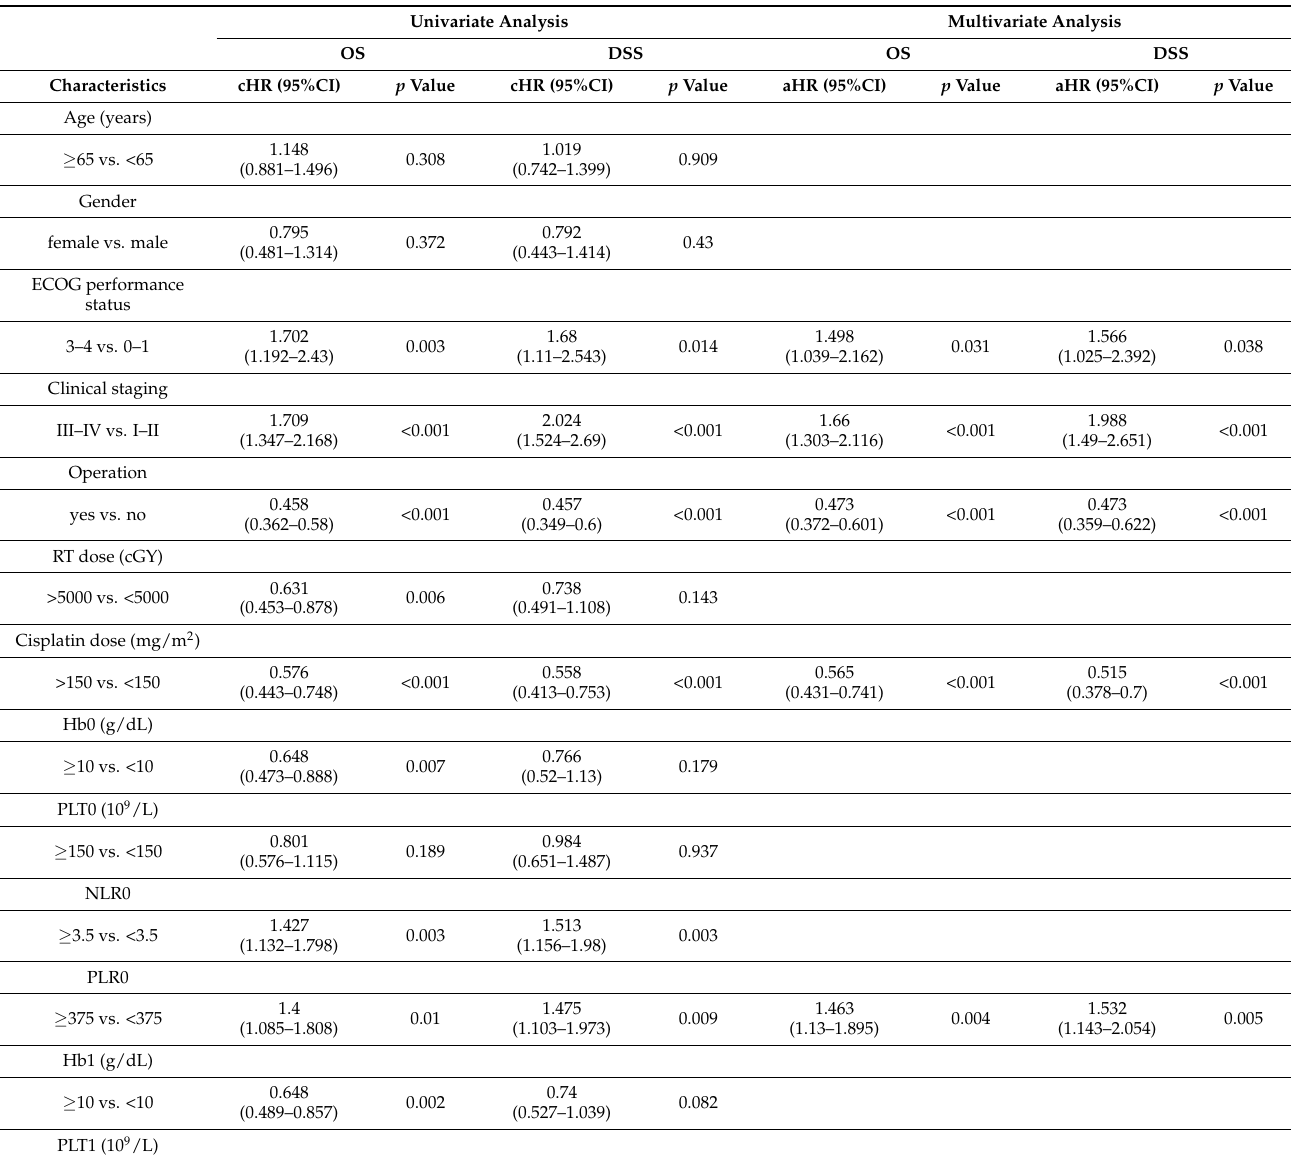
Table 2. Univariate Analysis and Multivariate Cox proportional Hazard Regression Analysis for OS and DSS. Univariate Analysis Multivariate Analysis OS DSS OS